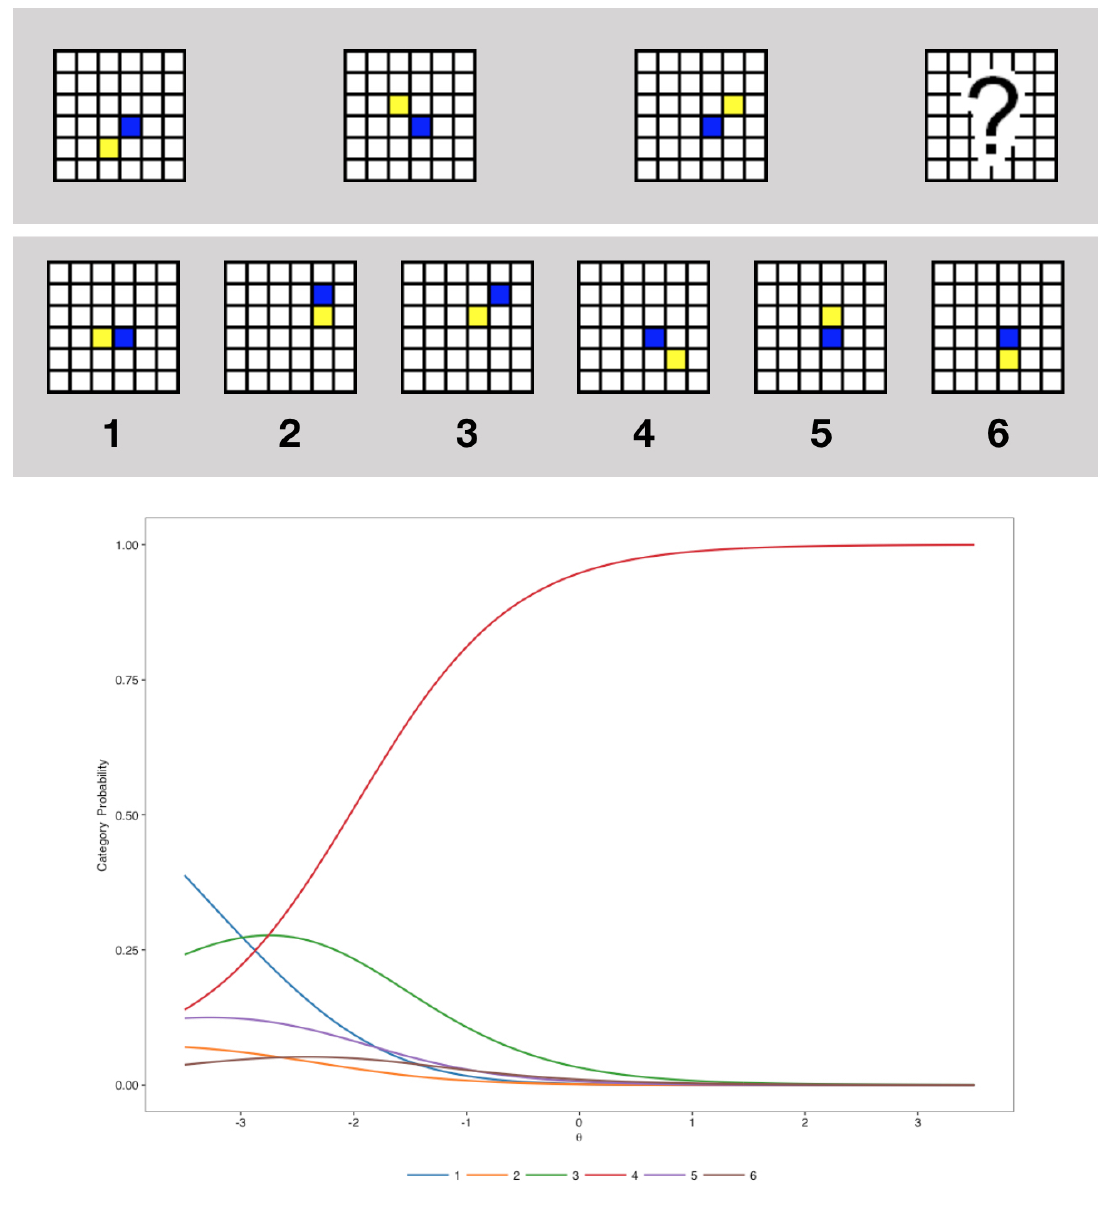
Figure 1. An example item of the GF20 ( top ) and the associated category characteristic curves as estimated by the 3-Parameter Nested Logit model ( bottom ). The correct response (4) is increasingly probable as θ j increases. However, the response category 3—which is the only distractor response where the blue and the yellow squares are (correctly) not adjacent—would be more probably selected by individuals with low abilities ( θ j ≈ − 2.7), while the category 1 would be more probably selected by individuals with even lower abilities ( θ j < − 3)—thus showing that the choice of distractor may be informative of θ j